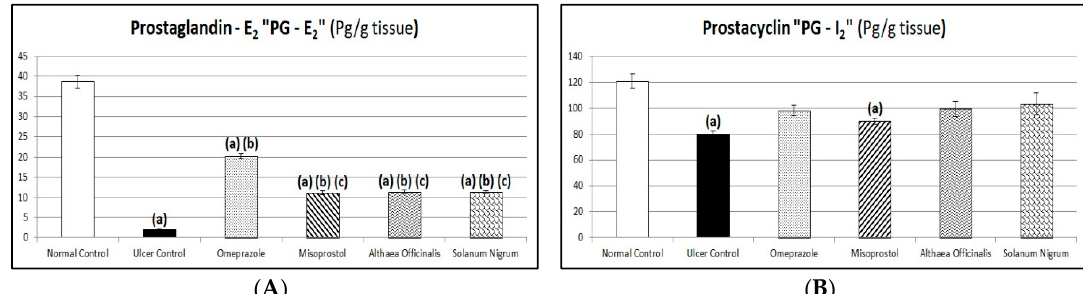
Figure 9. Protective effects of Althaea officinalis and Solanum nigrum with standards misoprostol and omeprazole on prostaglandin-E 2 “PG-E 2 ” ( A ) and prostacyclin “PG-I 2 ” ( B ) against pyloric-ligation/indomethacin-induced gastric-ulceration experimentally in male rats. Each value signifies the mean of 6–8 animals ± standard error of the mean. Statistical analysis was performed via one-way ANOVA test, and after that the Tukey–Kramer multiple comparisons test was done. Where: (a) indicates a significant difference from the normal control group ( p < 0.05), (b) indicates a significant difference from the gastric ulcer control group ( p < 0.05), and (c) indicates a significant difference from the omeprazole (1st standard pretreatment) group ( p < 0.05).